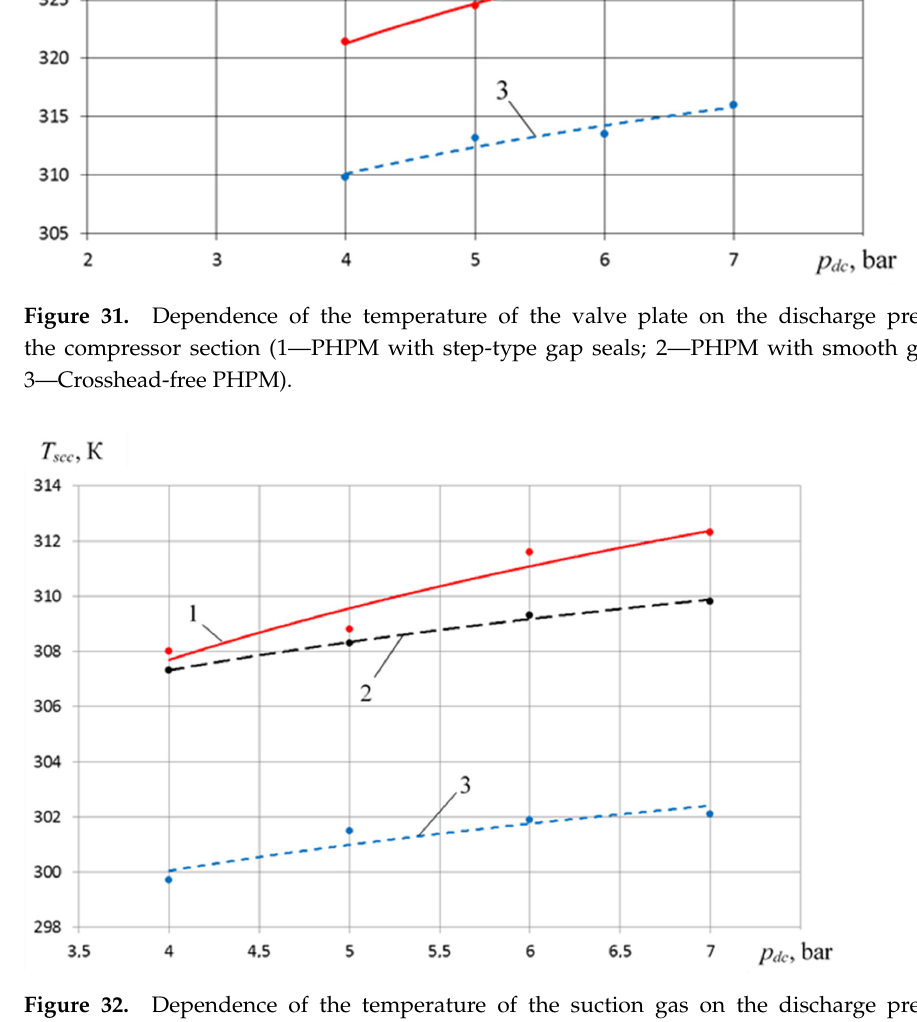
Figure 32. Dependence of the temperature of the suction gas on the discharge pressure of the compressor section (1—PHPM with step-type gap seals; 2—PHPM with smooth gap seals; 3—Crosshead-free PHPM).